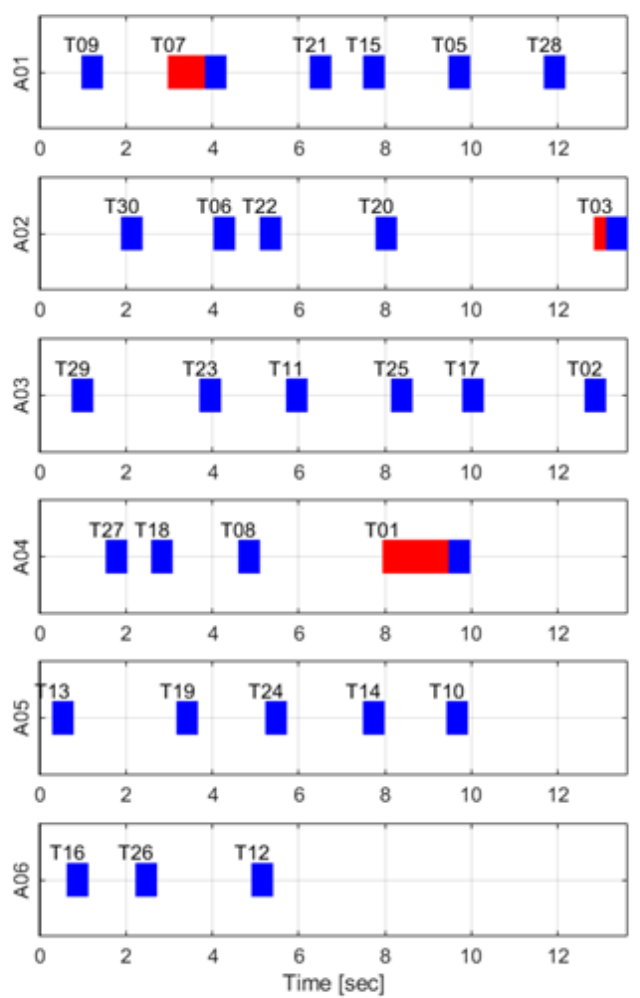
Figure 15. Timetable result of TACTAR for a huge case applying a modified time-discounted reward scheme.